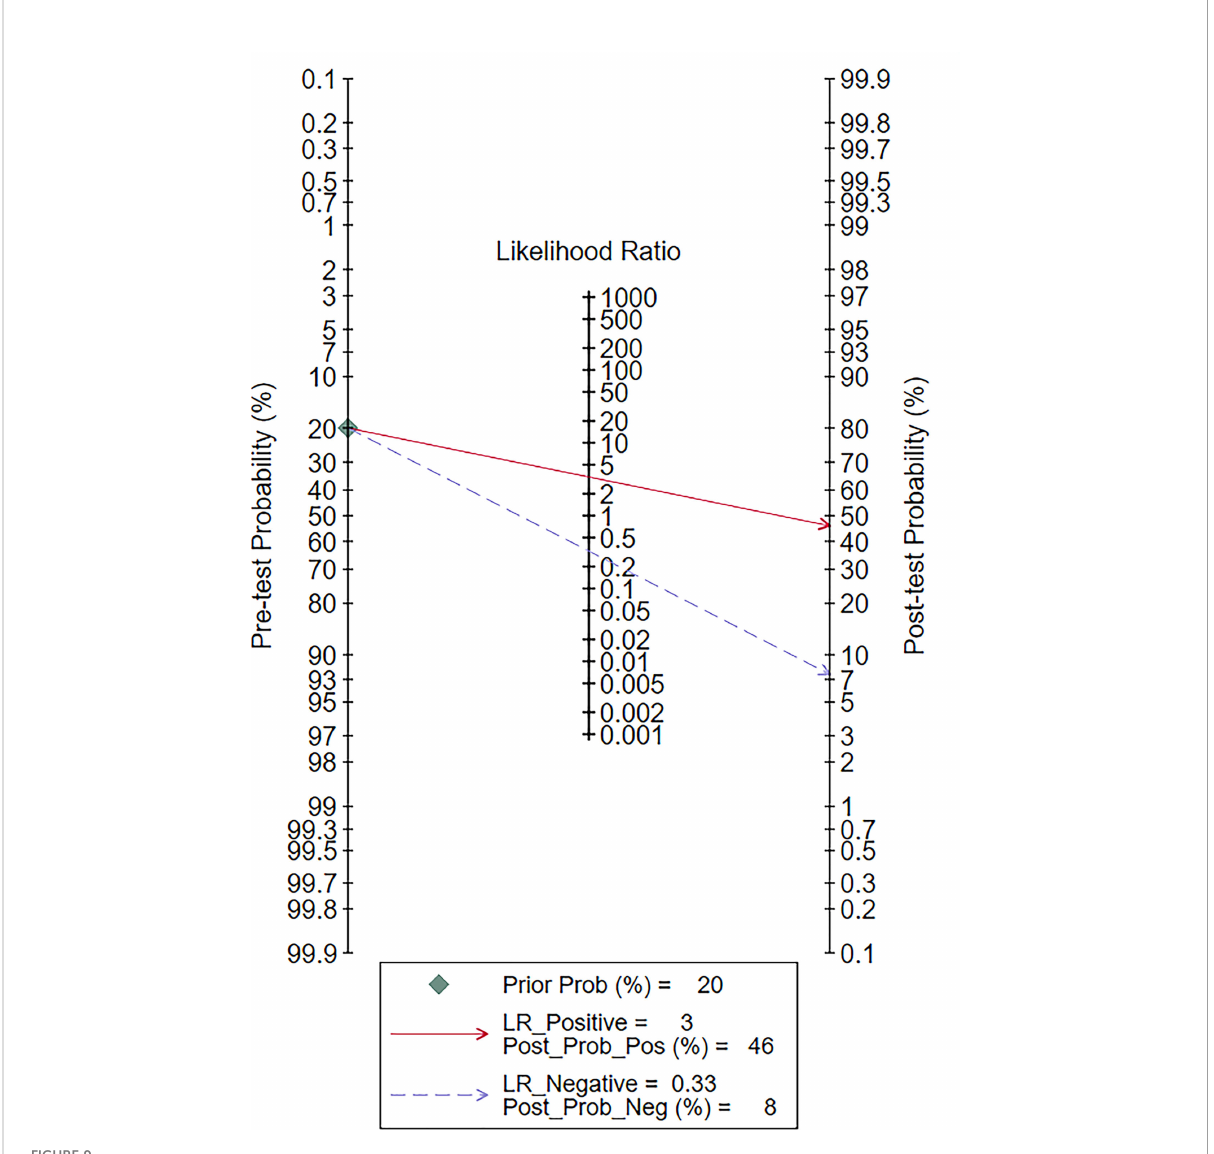
FIGURE 9 Fagan plot of elastosonography by patient analysis for the diagnosis of malignant salivary gland